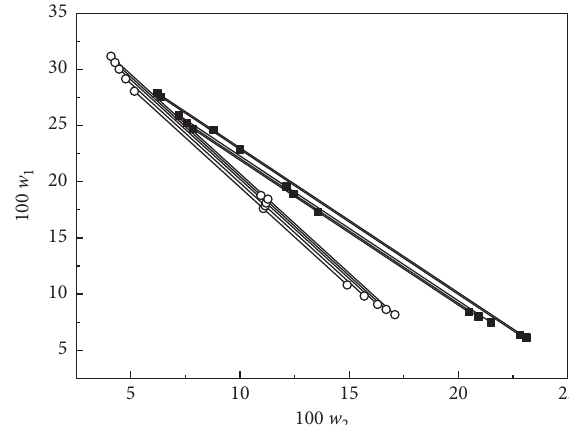
Figure 3: Effect of the binodal curves of the ATPSs composed of the alcohol mixture MA 2 � 0.333, salt Na 2 SO 4 /Na 2 CO 3 , and water at T � 308.15K; ■ Na 2 SO 4 ; ○ Na 2 CO 3 .